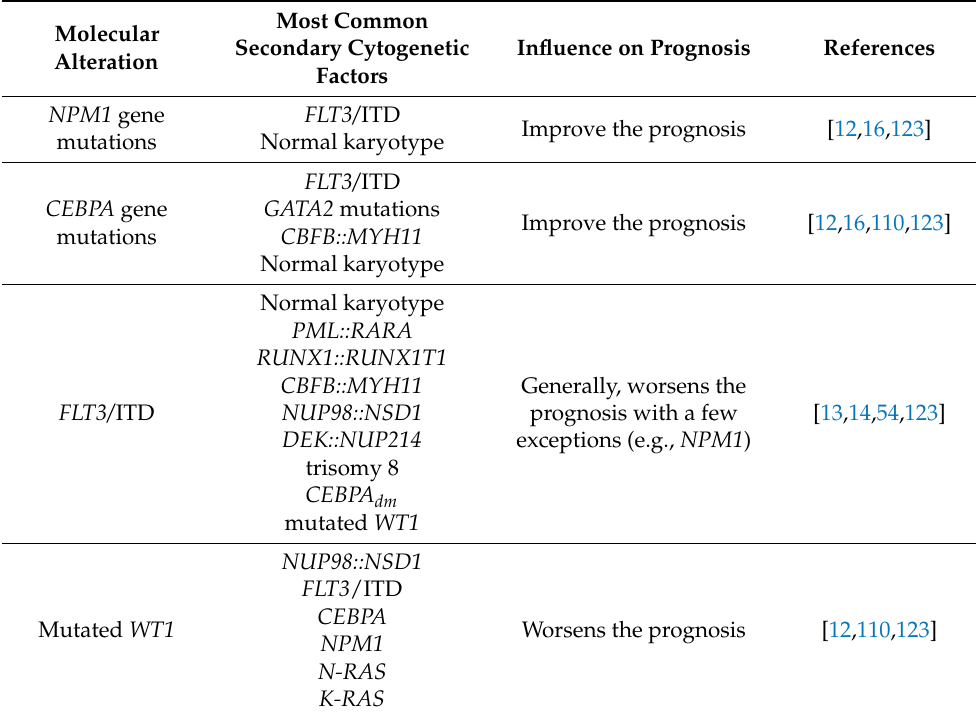
Table 3. Significant modifiers of prognosis in pediatric